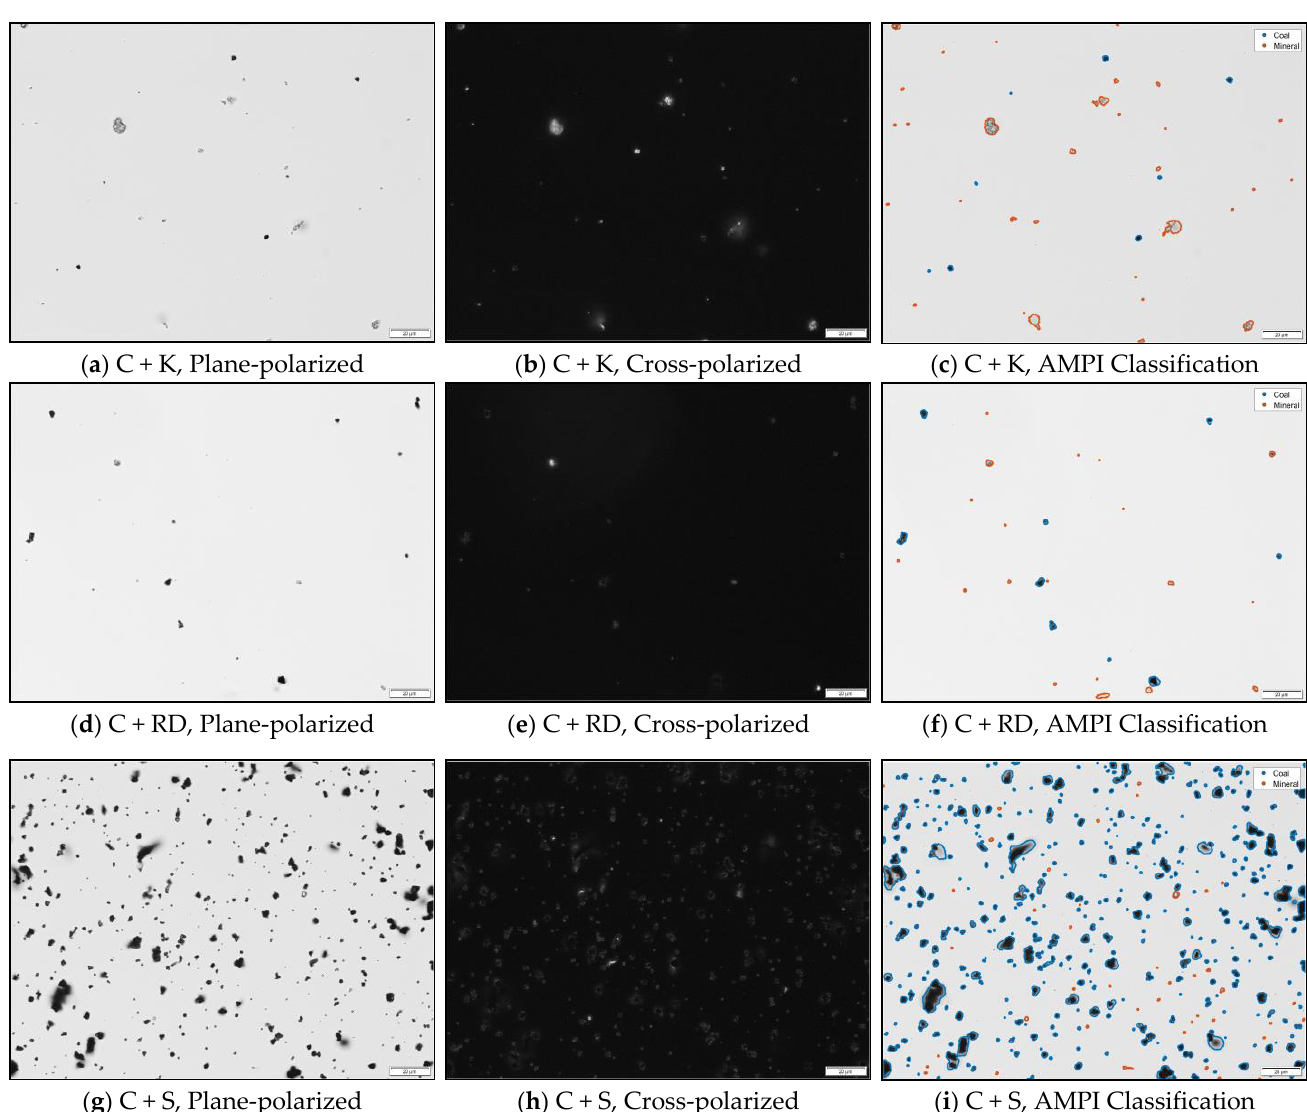
Figure 7. Coal versus mineral classification on composite samples containing ( a – c ) C + K, ( d – f ) C + RD, and ( g – i ) C + S. In each row, the left image shows the TPP input image, the middle image shows the TCP image, and the right image shows the model output with coal particles outlined in blue and mineral particles outlined in orange.